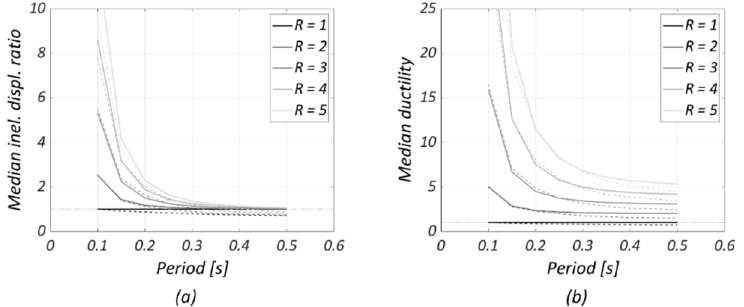
Figure 15. Comparison between the predictions by the MN2 method (solid lines) and the results from NLTHA of Suite 2-A (dashed lines): ( a ) median C R − R − T curves, and ( b ) median µ R − R − T curves.